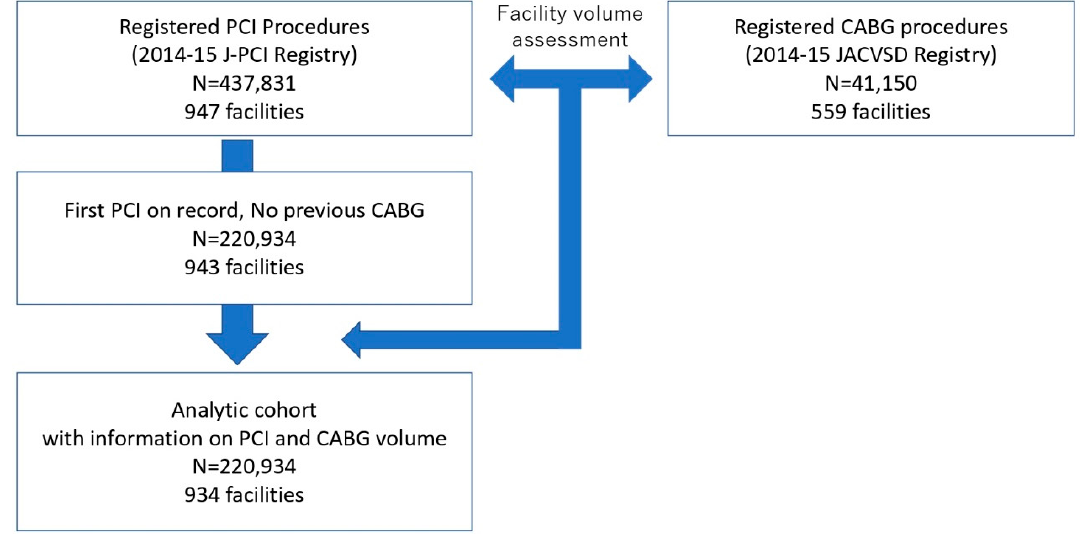
Figure 1. Study analytic flow.